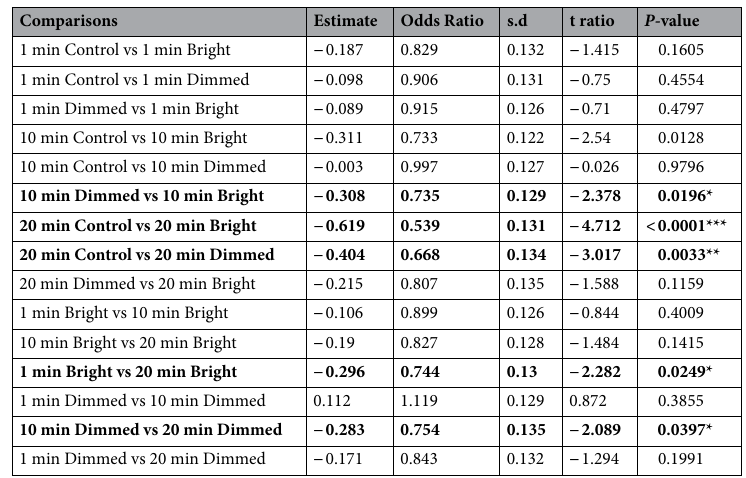
Table 2. Summary of the results of post-hoc pairwise tests for the interval experiment, showing the comparison of differences in bird count between experimental pairs (‘light-on’, ‘light-off’) and control pairs (‘light-off’, ‘light-off’) of various durations. Estimates taken from the GAM show log-transformed differences in counted birds. For example, 20-min bright white caused a (0.539–1) * 100% = − 46.1% decrease in counted birds when we turned on the light compared to 20-min control pair (‘light-off’, ‘light-off’). Significant results are marked in bold. *** P < 0.001; ** P < 0.01; * P < 0.05.